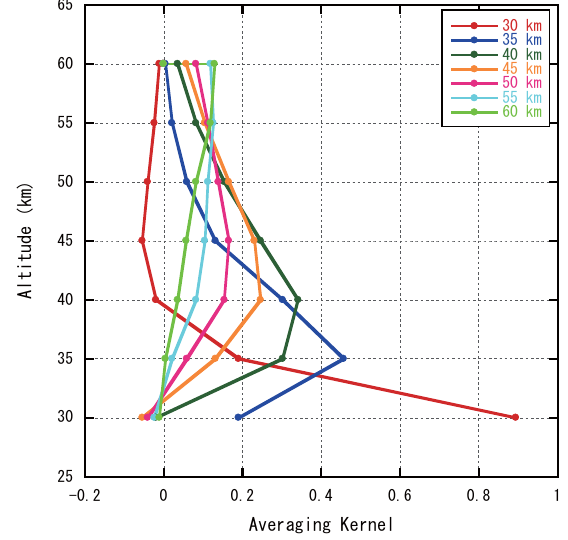
Fig. 5. Averaging kernels for the retrieval calculation between 30km and 60km.